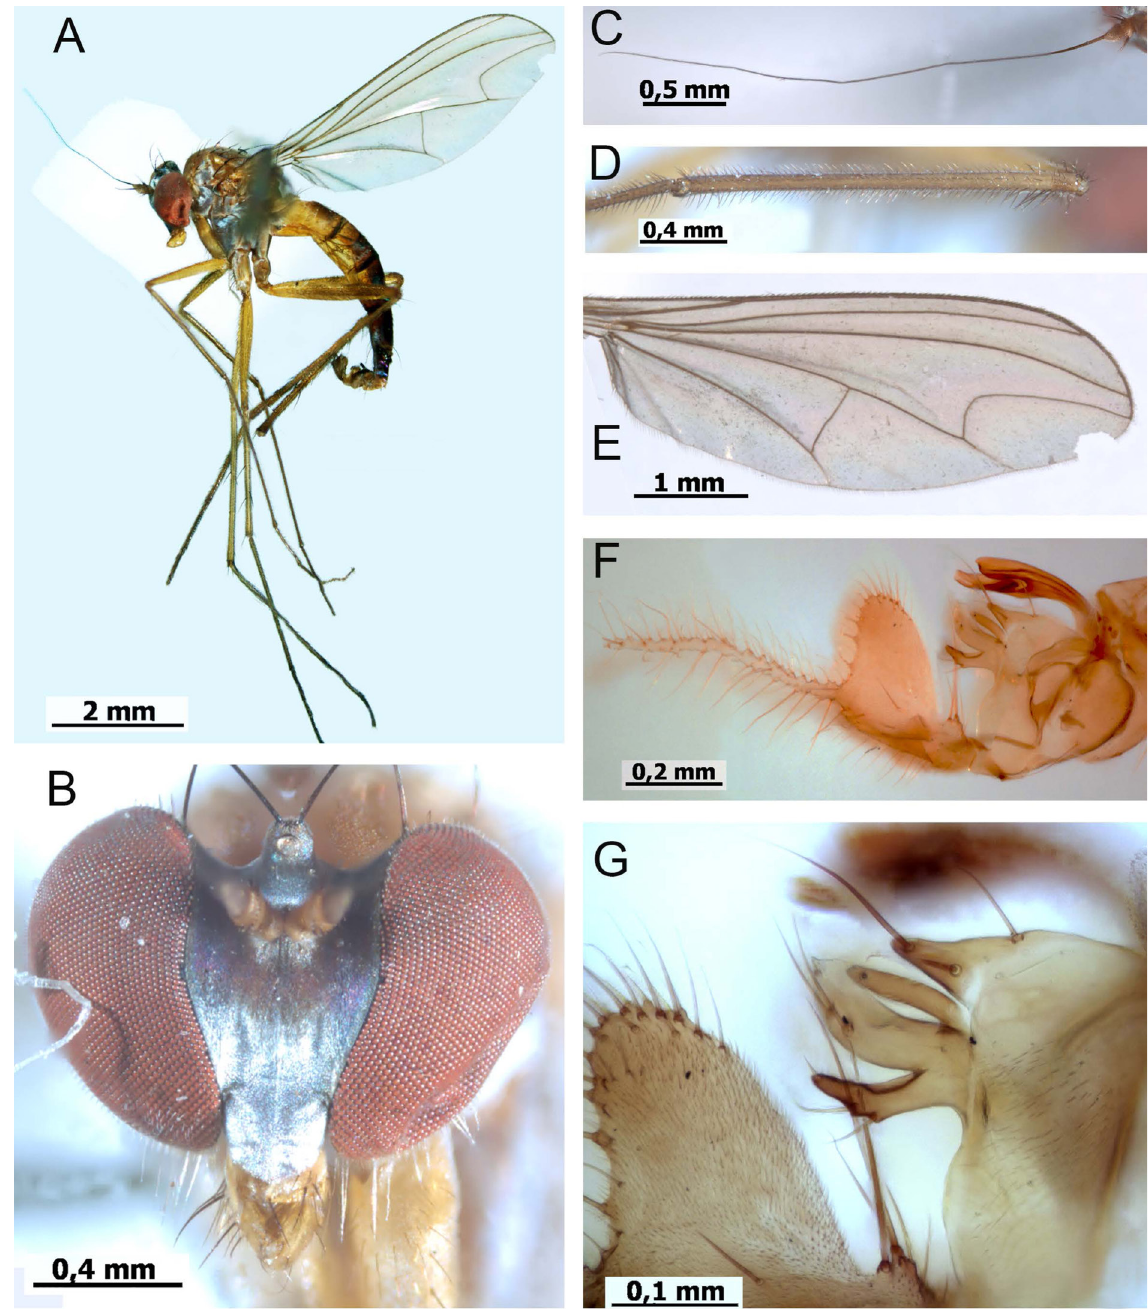
Fig. 2. Amblypsilopus bairae sp. nov. Holotype, ♂ (SMNHTAU). A . Habitus. B . Head. C . Antenna. D . Fore tibia. E . Wing. F . Hypopygium, left lateral view, reflected light. G . Epandrial lobe, surstylus and base of cercus, lateral view, transmitted